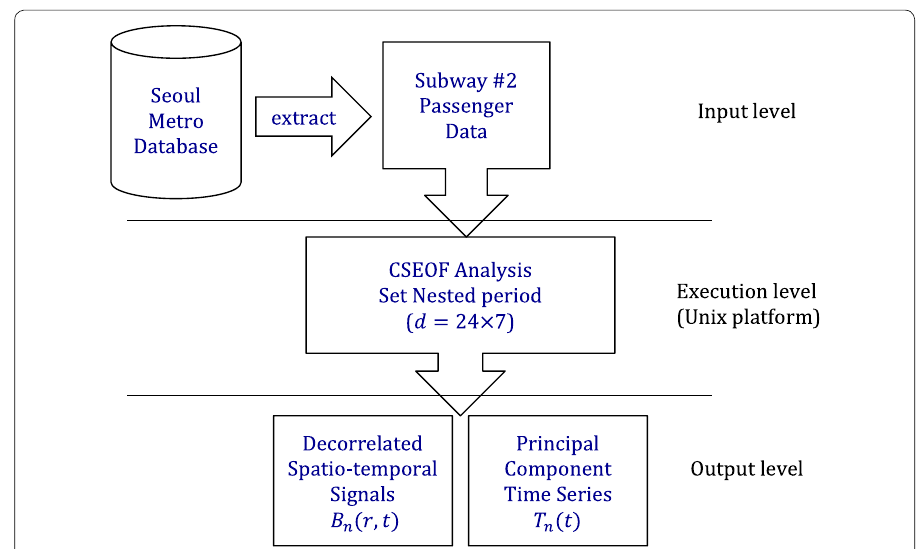
Fig. 1 A schematic diagram showing the analysis procedure for the Subway Line #2 passenger data